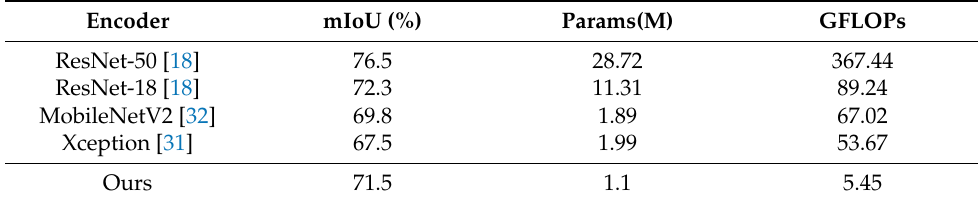
Table 4. Various types of encoders on Cityscapes.